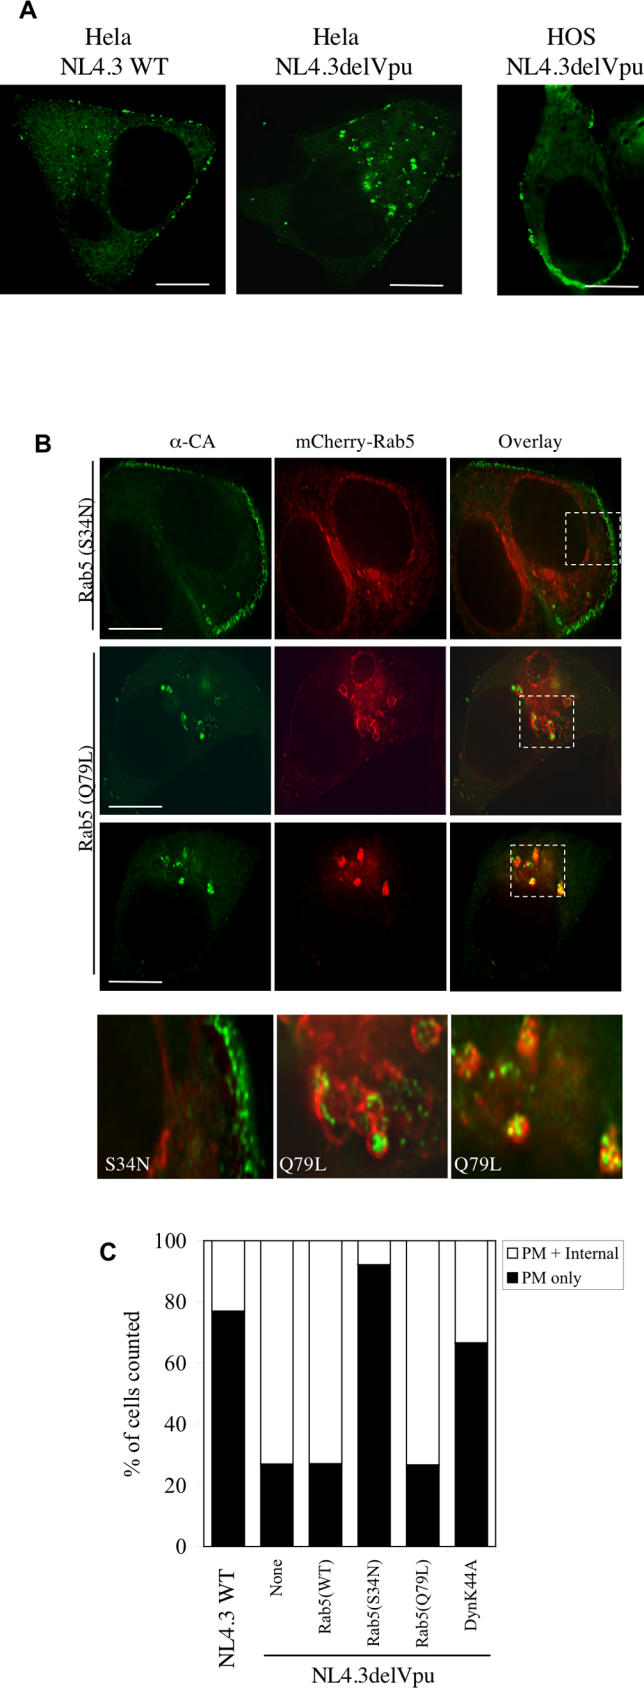
Immunofluorescent Localization of HIV-1 Gag Expressed from a Proviral Construct and Effects of Vpu and Endocytosis Inhibitors(A) HeLa cells (left and center panels) or HOS cells (right panel) were transfected with NL4.3 or NL4.3delVpu proviral plasmids, as indicated. Gag localization was determined by immunofluorescence using an α-CA antibody as described in Materials and Methods.(B) HeLa cells expressing Gag from the NL4.3delVpu proviral plasmid, and either DN (S34N, upper panels) or constitutively active (Q79L center and lower panels) mutants of CherryFP-Rab5a (red), were fixed and subjected to immunofluorescence to detect HIV-1 Gag (green) at 20 h post-transfection. White bars in the micrographs indicate a distance of 10 μm. The lower three images in (B) show expanded views of a portion of the overlay panels (indicated by the dashed squares) to exemplify how HIV-1 Gag and the CherryRab5a proteins are juxtaposed, Note that Gag sometimes appears to be within the lumen of the CherryFP-Rab5a(Q79L)–marked endosomes.(C) The numbers of HIV-1 Gag–expressing cells in ten fields exhibiting PM Gag immunofluorescence only (black bars) or additional intracellular accumulations (white bars) after transfection with NL4.3 or NL4.3delVpu proviral plasmids in the presence of the indicated co-expressed cellular proteins was counted, as in Figure 2C. Data are plotted as a percentage of the total number of cells with visible Gag accumulations.